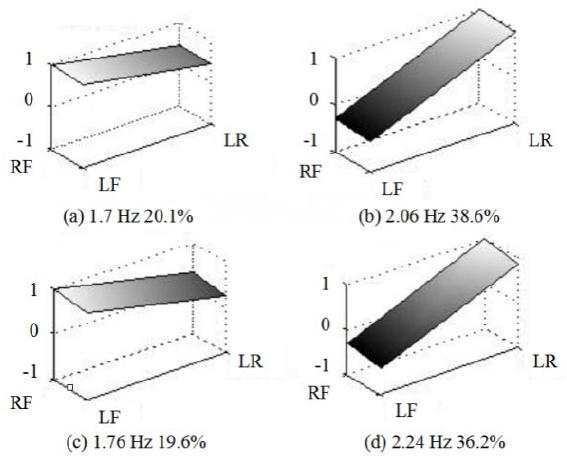
Figure 13. Differences of mode shape between baseline and spring fault. RF: Right-Front; LF: Left-Front; LR: Left-Rear.